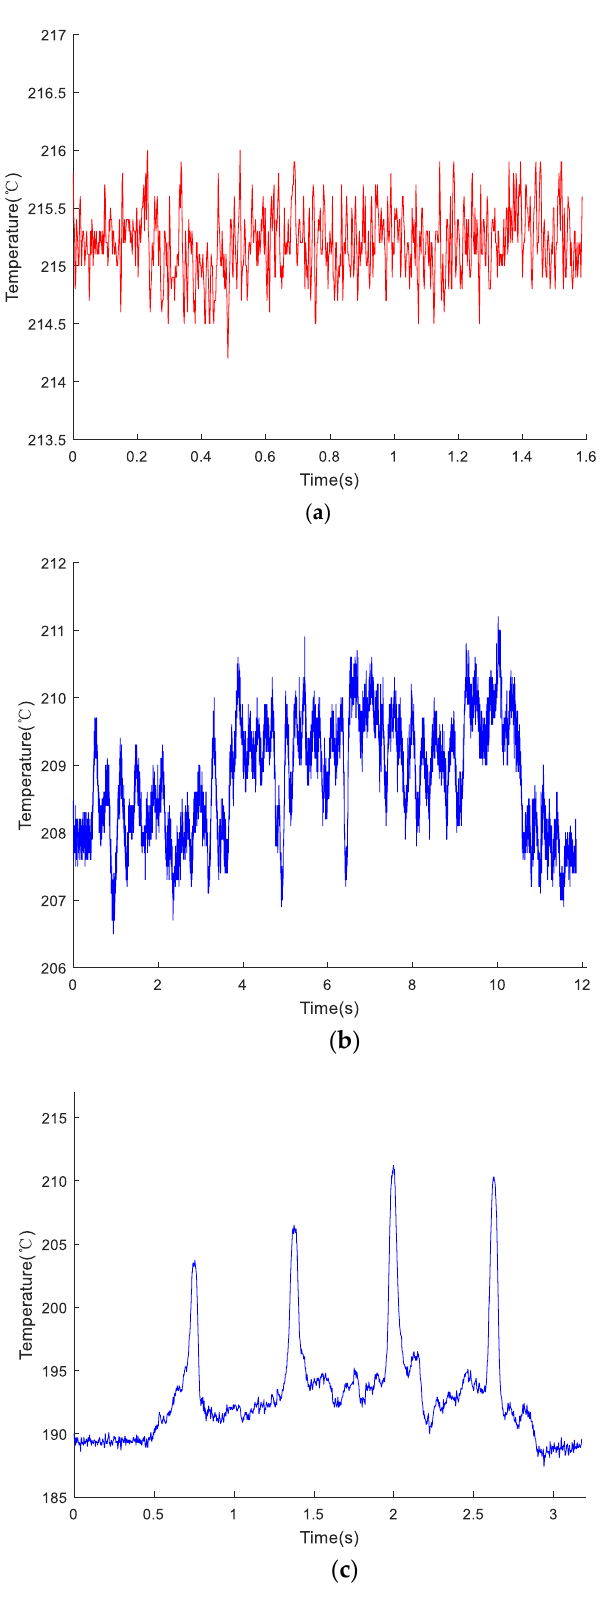
Figure 6. Collected temperature data using the IMP. ( a ) Temperature changes of the upper surface of the furnace; ( b ) Temperature changes of the upper surface of the non-defective LMD sample; ( c ) Surface temperature changes with time of a defective LMD sample.